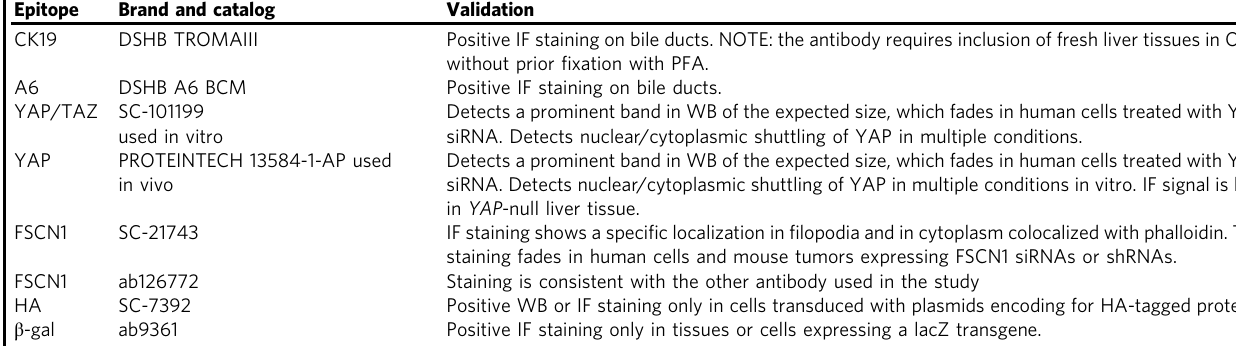
Table 2 Antibodies. Epitope Brand and